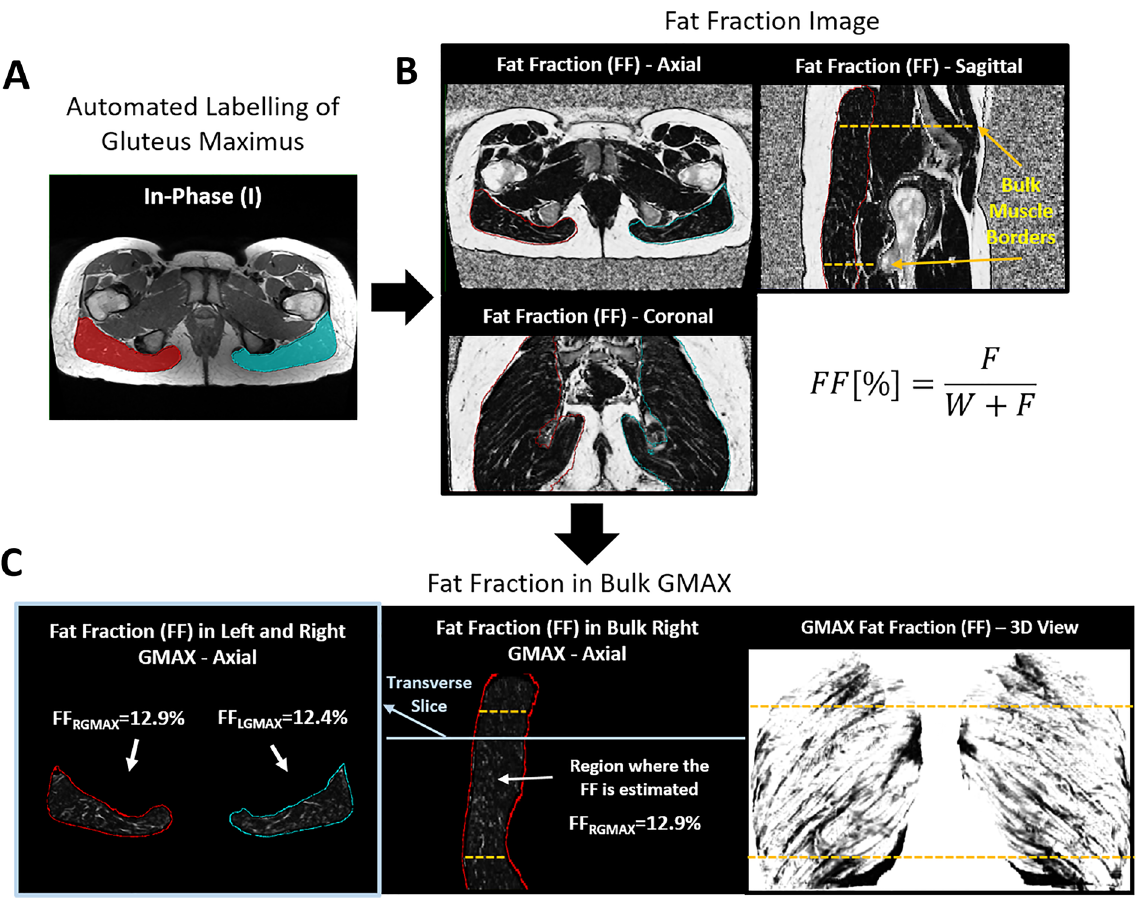
Figure 1. FF measurement of GMAX. ( A ) An automated tool is used to label the in-phase Dixon image. ( B ) A FF image is created from fat and water images where the labels are overlaid and landmarks for the bulk muscle are identified. ( C ) FF of right and left GMAX are estimated by masking the FF image with the labels. A coronal view of the masked FF image is shown, where the central region between dashed lines is used to estimate the FF. On the left an axial slice of the masked image (highlighted in the coronal view) is found. On the right, a 3D view of the FF in both gluteus maximus is shown where a dark signal indicates fat